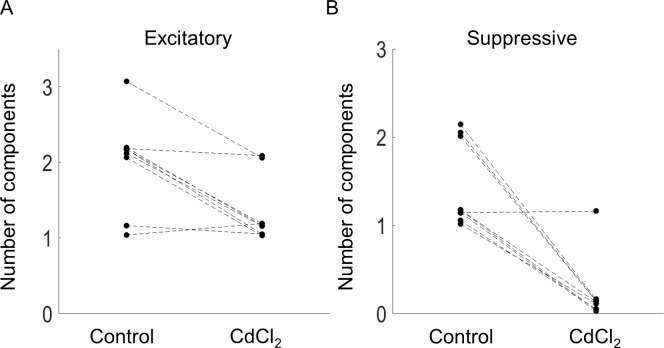
Number of excitatory (A) and suppressive (B) components before and after application of synaptic transmission blockers (CdCl2).